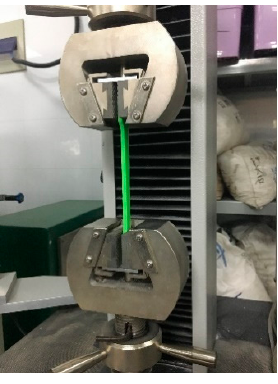
Figure 20. The tensile test.